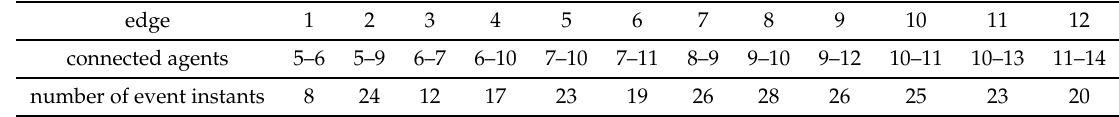
Figure 5. Event instants on edges 1–12 ( τ = 0.1, 30 s). Table 3. Number of event instants of each edge ( τ = 0.1, 30 s).